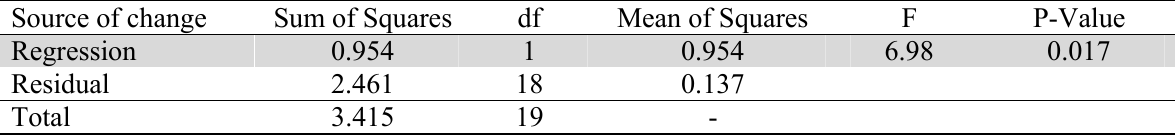
The results of ANOVA